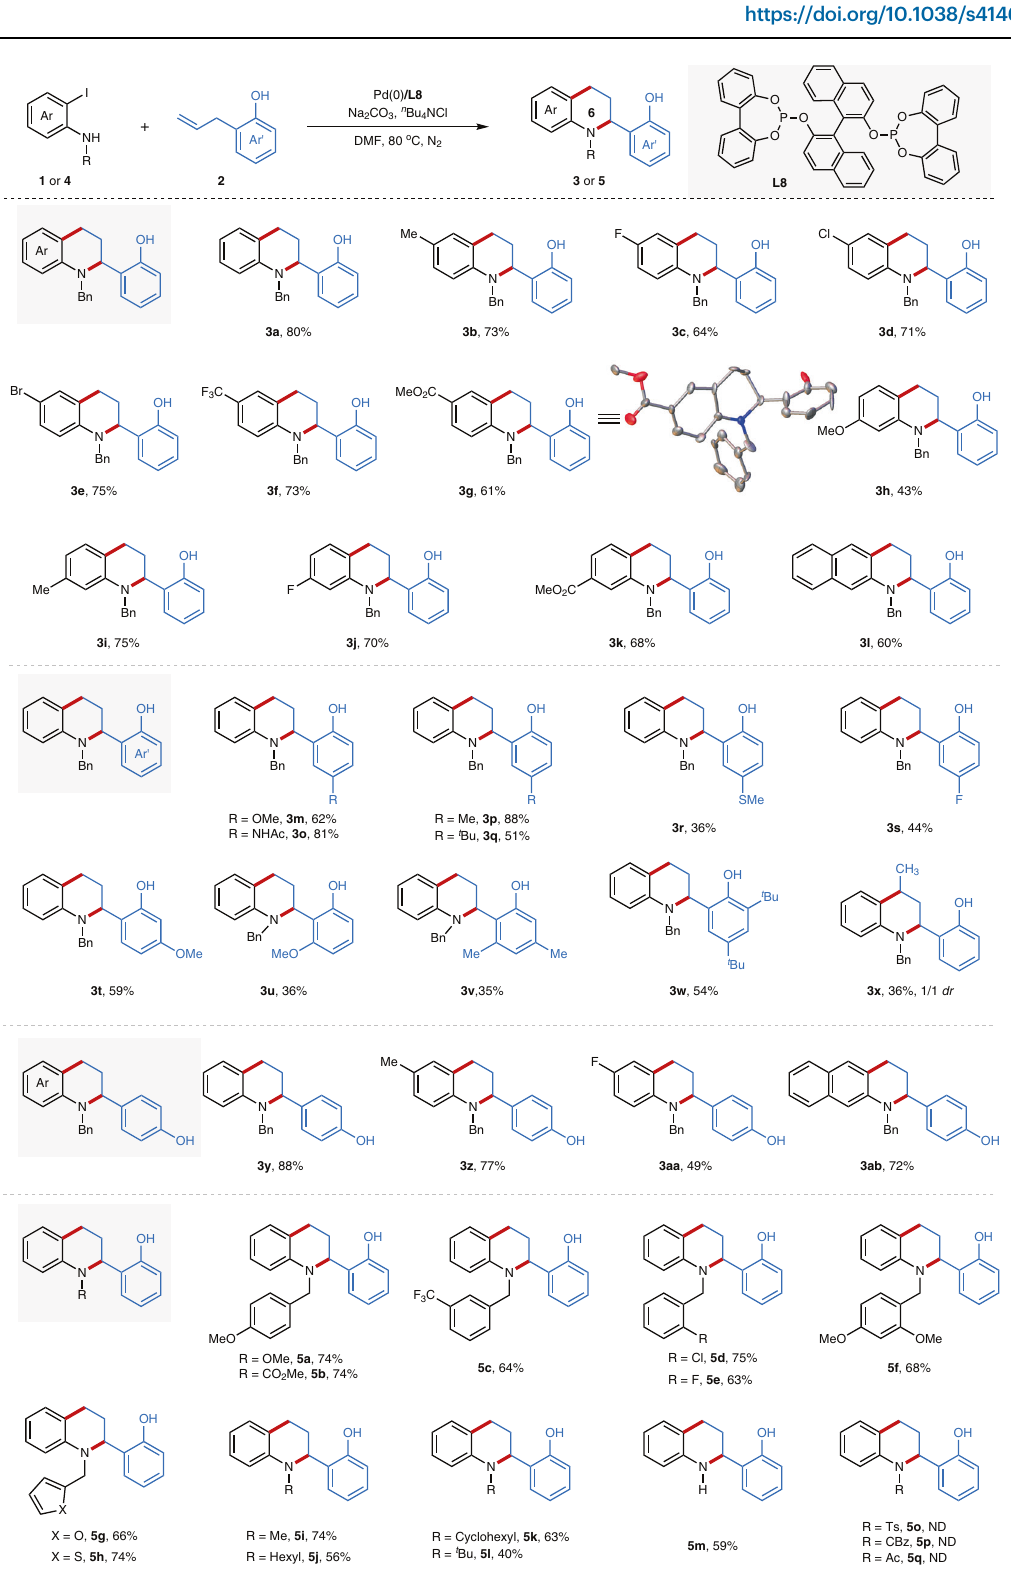
(3.0mL), 80°C, 18h. For 5i , the reaction was conducted for 24h. Bn, benzyl; Me, methyl; t Bu, tert -butyl; Ar, aryl; Ac, acetyl; Ts, 4-toluolsulfonyl; Cbz, benzylox- ycarbonyl; DMF, N , N -dimethylformamide; ND, not detected., dr , diastereomeric